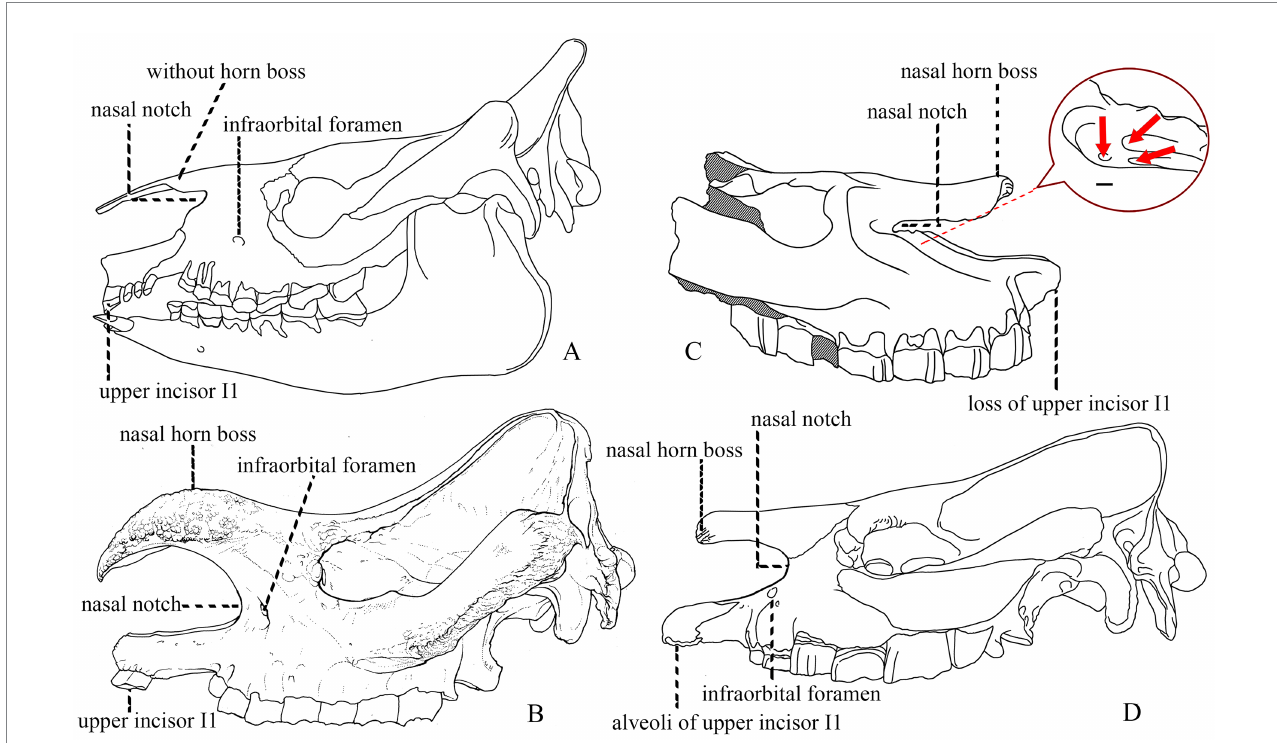
FIGURE 3 Skulls of rhinocerotids. (A) Trigonias osborni , AMNH 9847, Scott (1941). (B) Rhinoceros unicornis , IVPP OV 1383, new specimen. (C) Shansirhinus ringstroemi , Qiu and Yan (1982), the red circle marks three infraorbital foramina. (D) Teleoceras fossiger , Osborn (1900). Not to